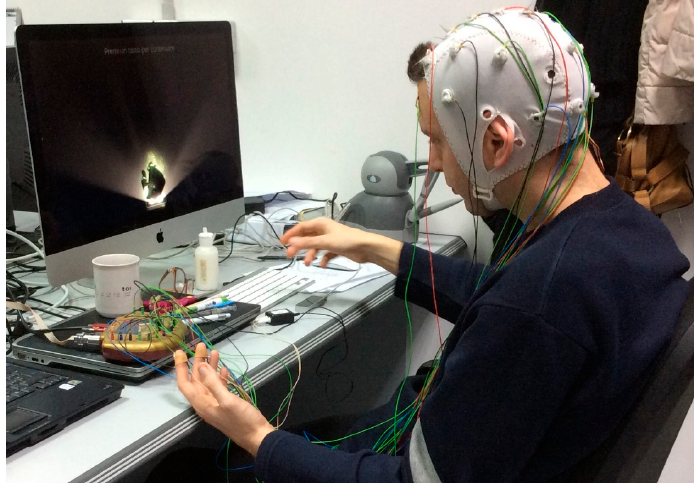
Figure 3. Subject during virtual training with Leap Motion.